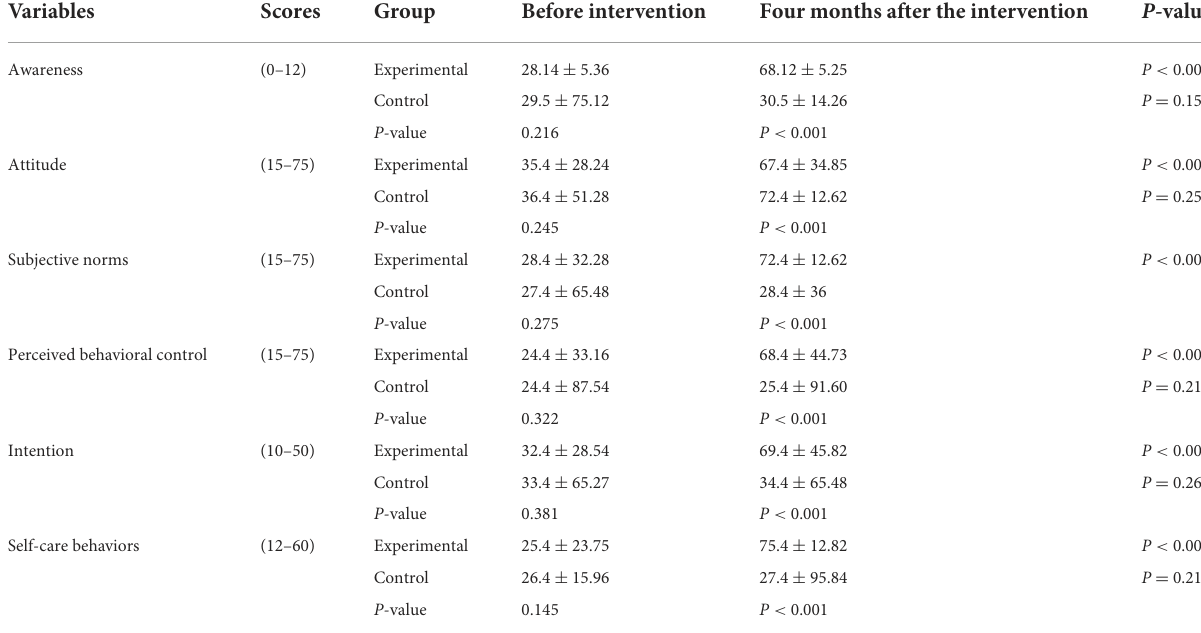
TABLE 3 Comparing the average scores of knowledge, attitude, subjective norms, perceived behavioral control, intention, and self-care behaviors in experimental and control groups 4 months after the educational intervention.